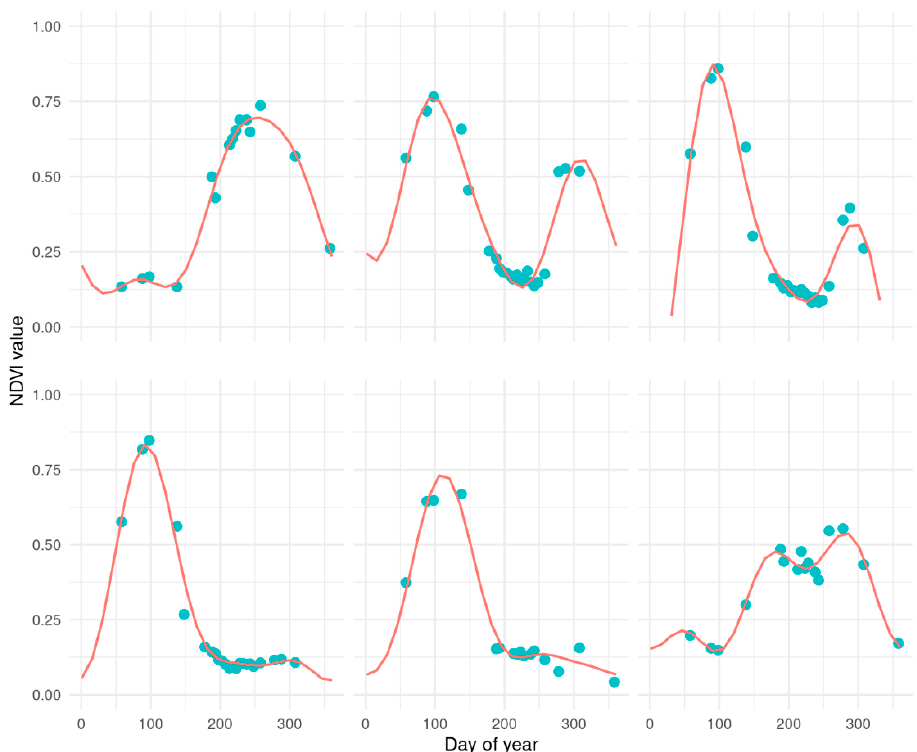
Figure 2. Six exemplary sample points of NDVI values collected for year 2017 (cyan dots) and harmonic models of time fitted to them (red lines). Missing NDVI values were due to cloudy image removals and clouds masking.